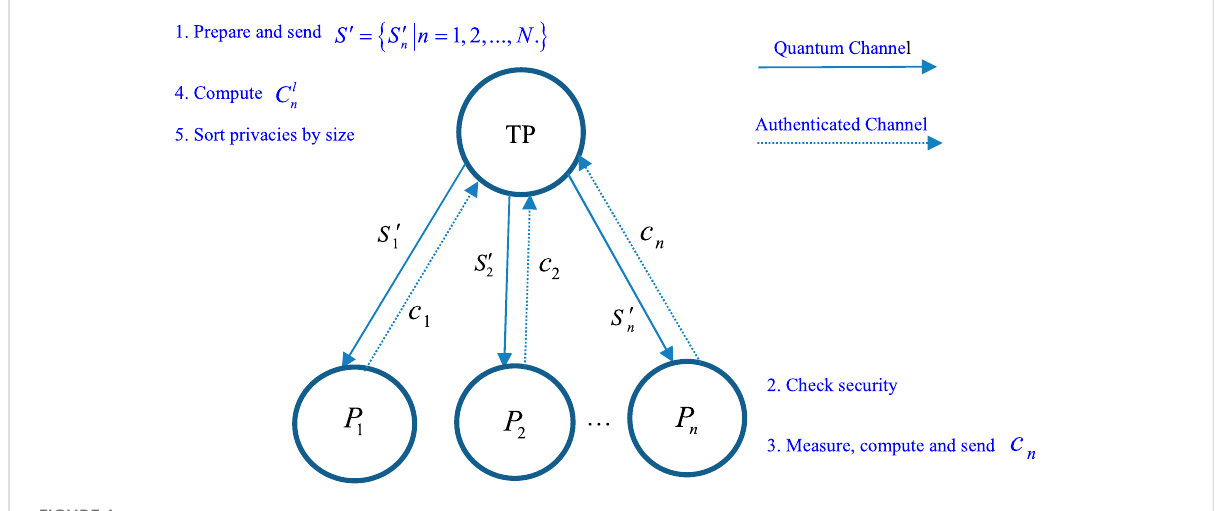
The schematic fi gure of the proposed protocol. The TP needs to implement steps 1 , 4, 5 and each participant needs to implement steps 2,